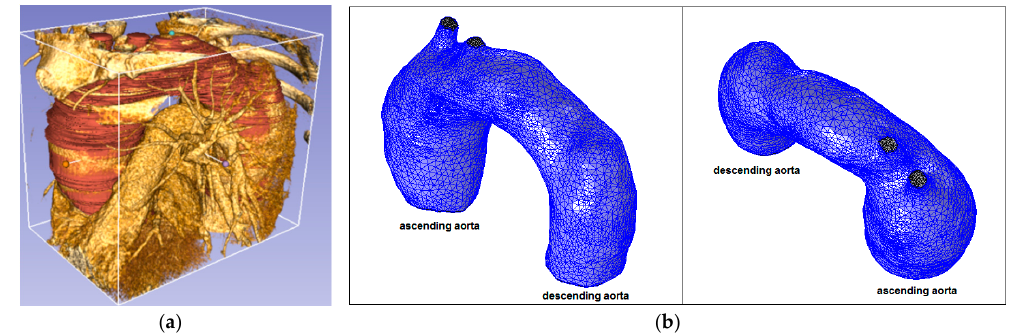
Figure 6. Ascending aorta aneurysm (Patient 1): ( a ) computed tomography (CT) data and segmentation; and ( b ) mesh.